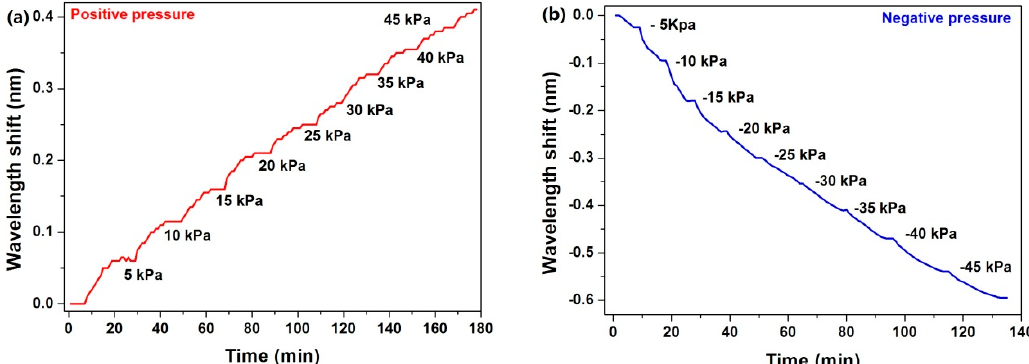
Figure 7. Step response of the sensor in negative/positive pressure atmosphere—positive ( a ) and